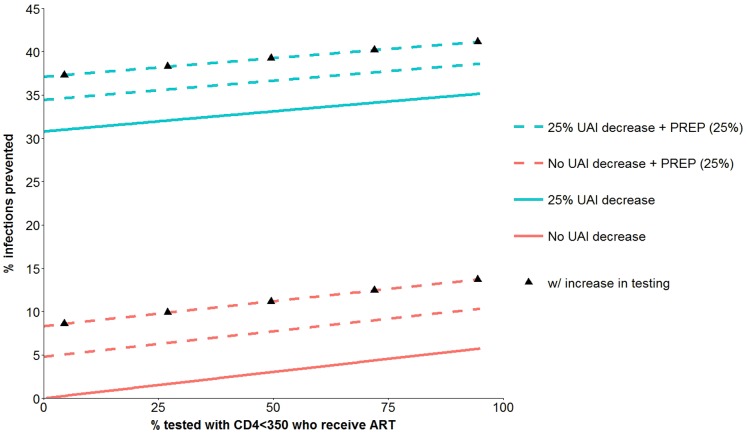
HIV infections prevented over 5 years from combination prevention interventions with four components.ART coverage of eligible persons who were not already receiving ART at baseline, PREP with 25% acceptance (dotted lines), 25% UAI reduction (blue lines; no UAI change are in red) and increase in HIV testing (black triangles). See Table 1 for further details about the components of the prevention interventions.